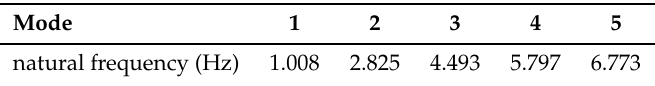
Table 1. Natural frequencies of the five-story building model.